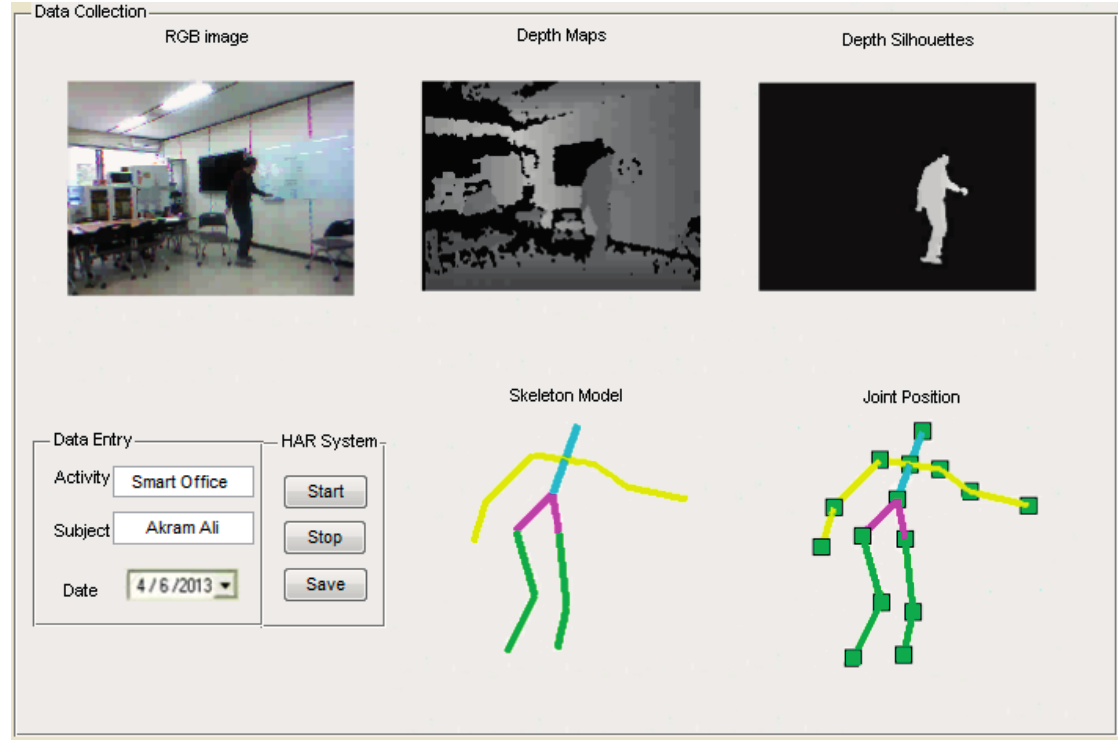
Figure 12. Data collection during training phase of life logging HAR system.